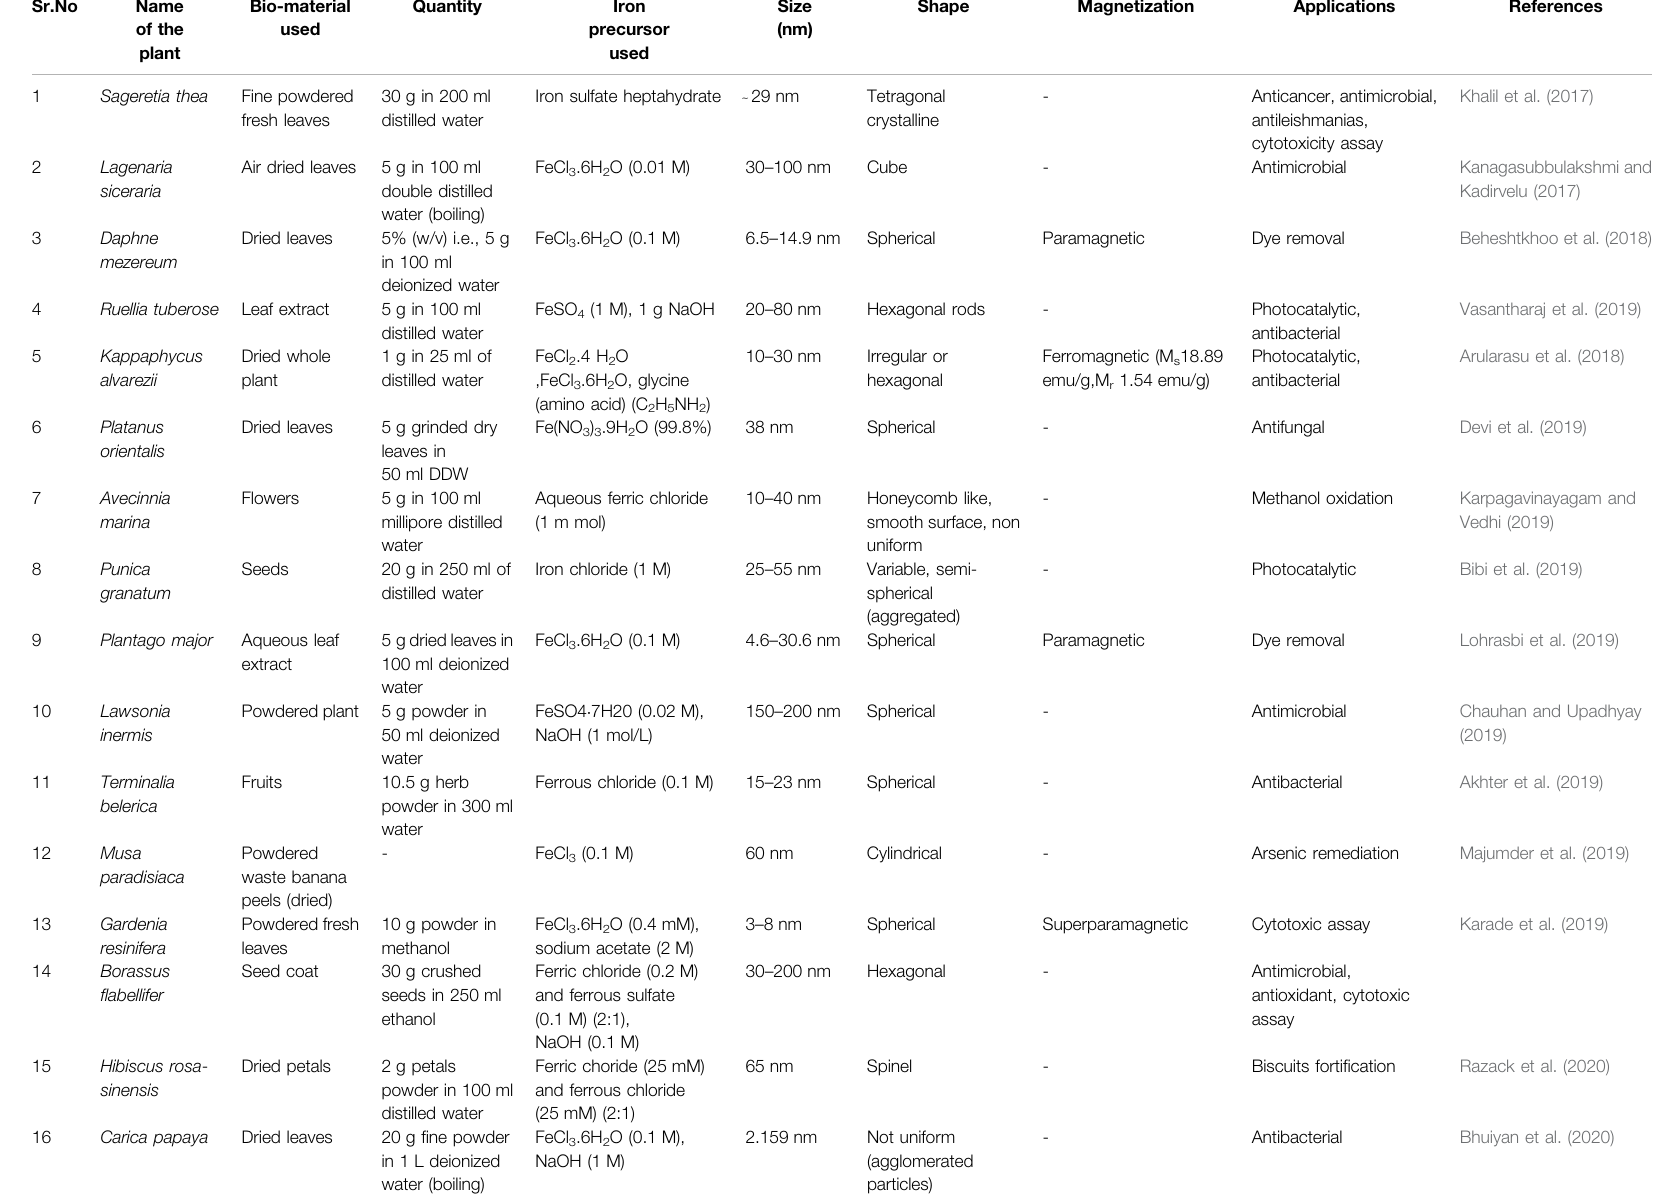
TABLE 1 | Biosynthesis of Iron oxide nanoparticles by using